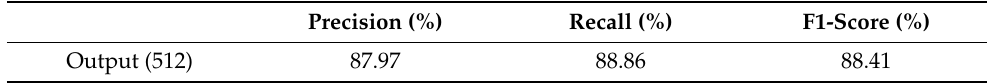
Table 2. Results of the evaluation